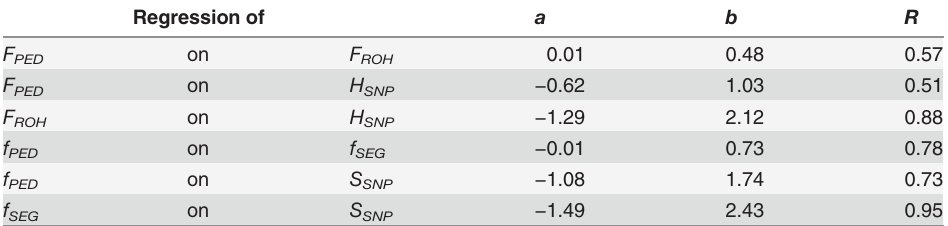
Table 2. Intercept ( a ), regression coefficient ( b ) and correlation ( R ) between different estimates. Regression of a b R F PED on F ROH 0.01 0.48 0.57 on on f PED on S SNP 0.73 S − 1.49 2.43 0.95 f SEG on SNP F PED : pedigree-based inbreeding; F ROH : inbreeding based on ROHs; H SNP : SNP-by-SNP based